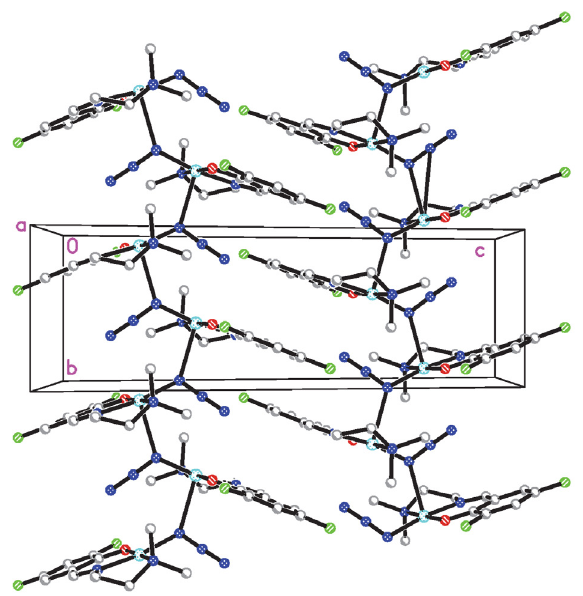
Figure 2. Molecular packing structure of complex 1 , viewed along the b axis.